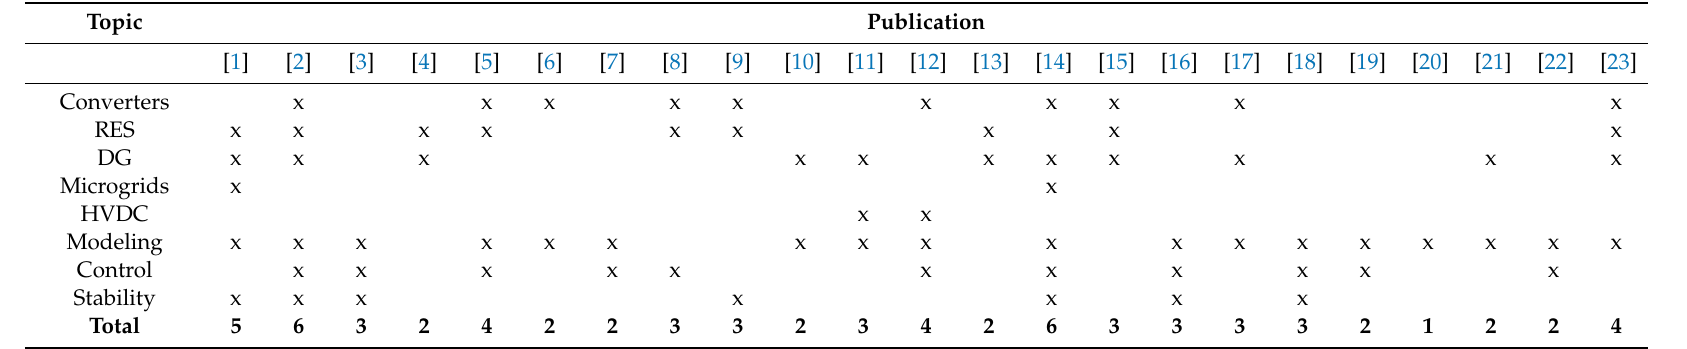
Table 1. Topics covered in each